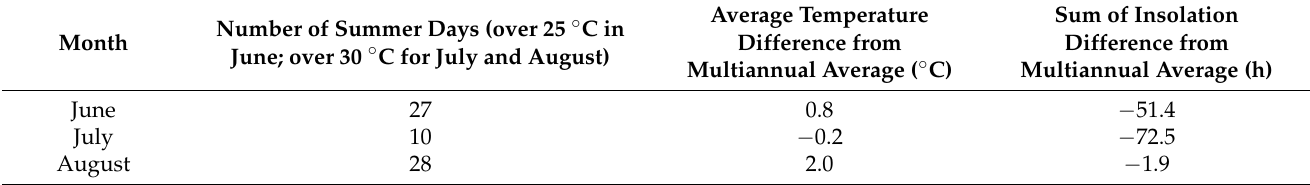
Table 1. Climatic conditions characterizing production season in which investigations were conducted. Number of Summer Days (over 25 ◦ C in Month June; over 30 ◦ C for July and August)